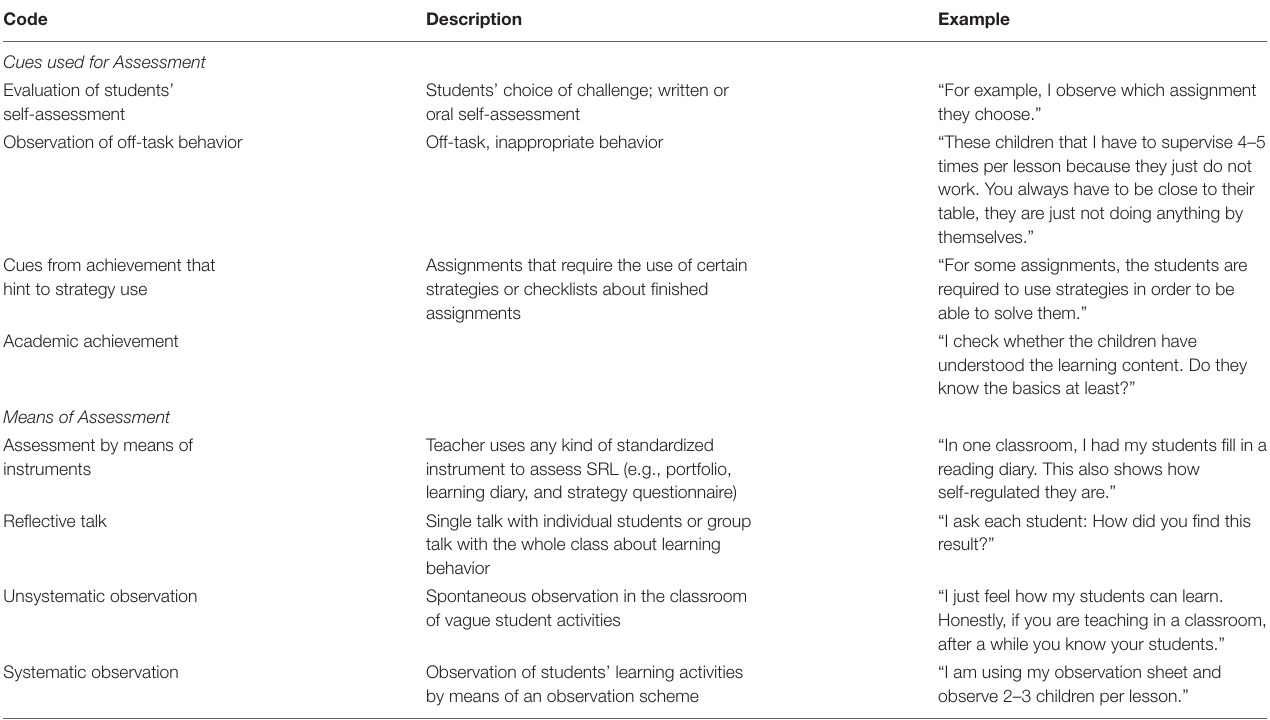
TABLE 2 | Answering codes for teachers’ ideas about assessing